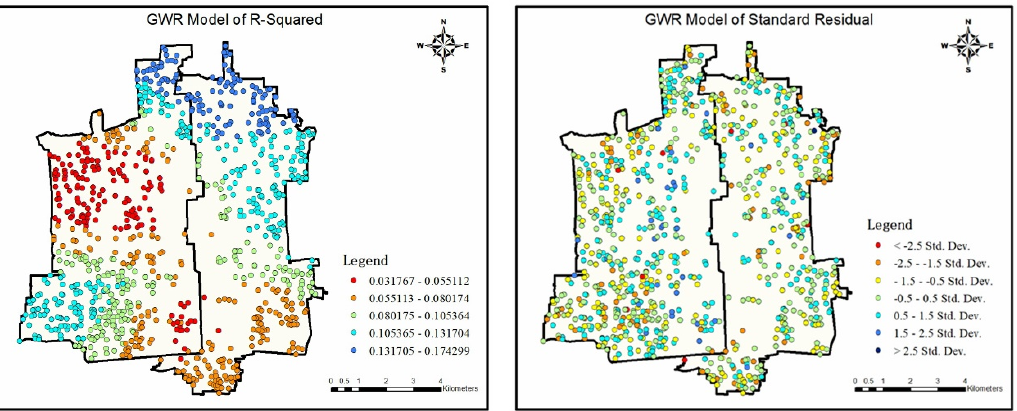
Figure 3. Distribution of R 2 and standard residual of the GWR model.